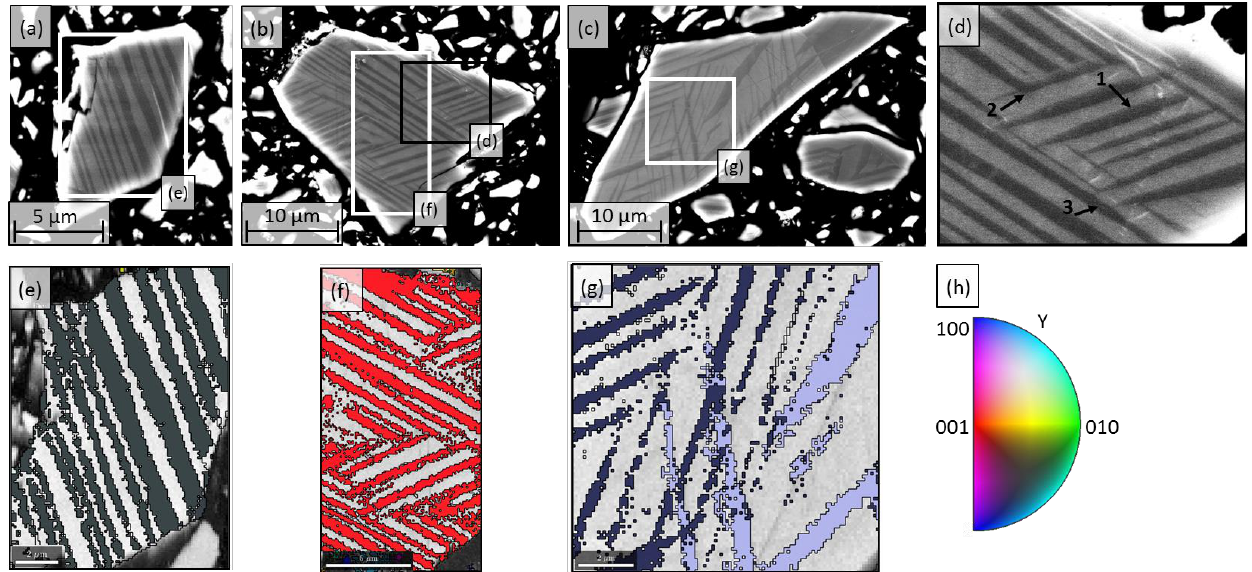
Figure 2. ( a – c ) Backscattered electron contrast image of the cross sections of powder particles with dark plates of the η′ phase in a lighter η matrix. ( d ) Typical characteristics of the bands in detail. 1 — tapered ends close to plate intersections, 2 — rounded intersections between the plates, 3 — modulations of non-intersecting plates close to intersections. ( e – g ) The corresponding EBSD maps after final indexing. The η matrix is shown in EBSD band contrast (gray scale). The plates consisting of η′ phase are indexed using the pseudo-orthorhombic subcell given in Table 2 and are colored according to inverse pole-figure (IPF) color code in ( h ) with respect to the y direction of the maps.